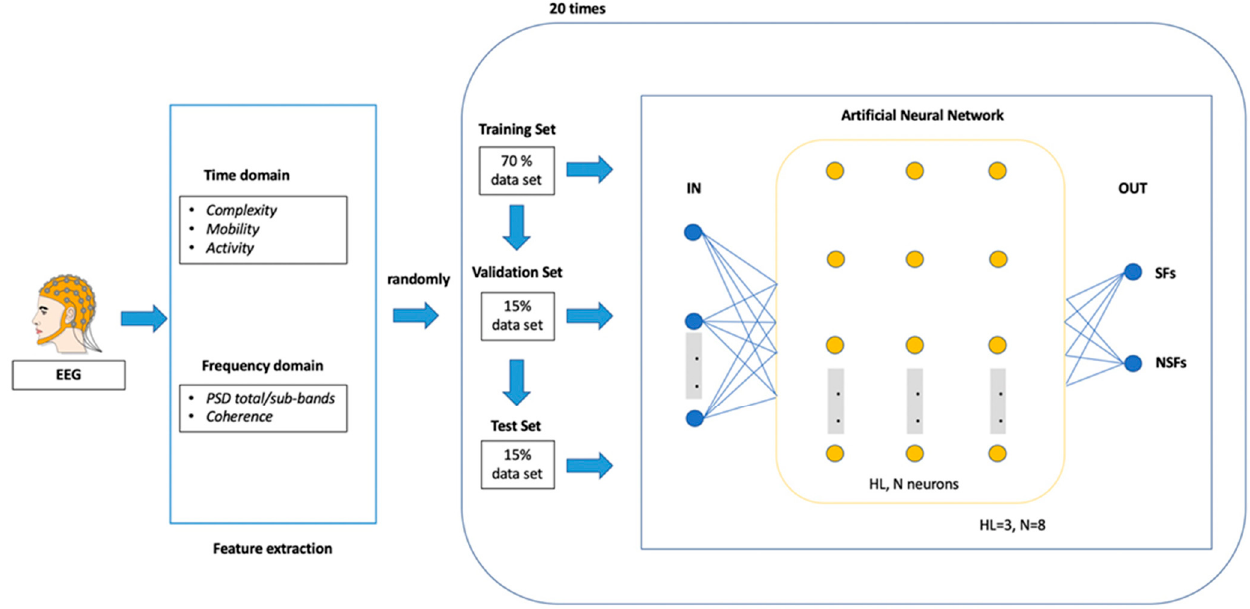
Figure 2. Artificial Neural Network (ANN) architecture of the model.